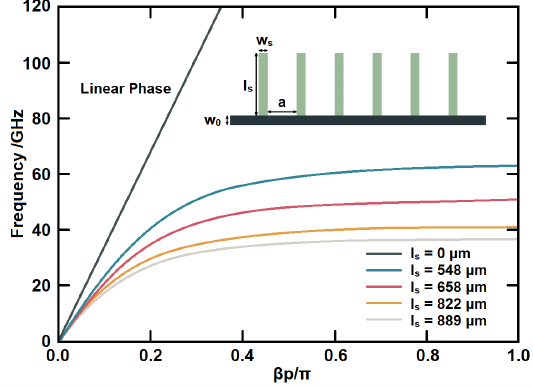
Figure 5. The dispersion curve of SSPP unit structure.